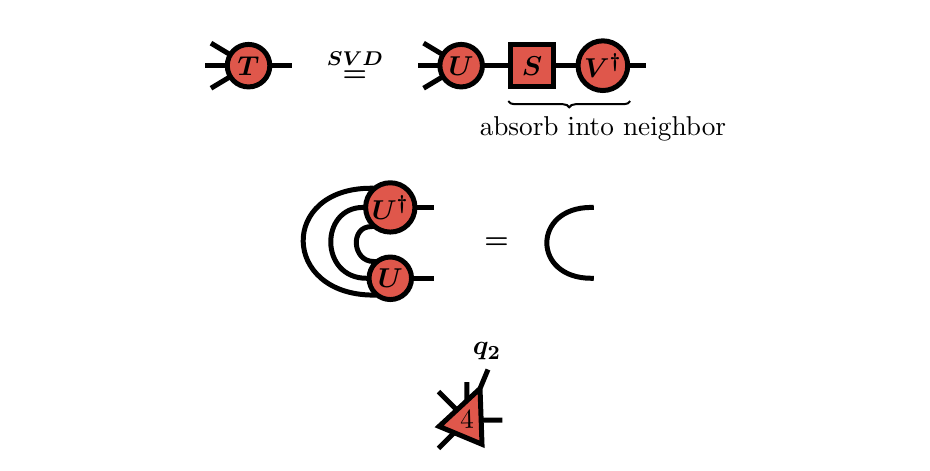
Figure 3: With an SVD, we can orthogonalize a tensor towards one of its neighbors with which it shares an index. Top: Tensor T is reshaped into a matrix and the U - matrix of its SVD is used as new tensor. S · V † is absorbed into the neighboring tensor. Middle: Graphical representation of U † · U = (cid:49) . Bottom: A tensor that is normalized towards one of its neighbors is depicted as a triangle pointing in the direction of this neighbor. The picture shows tensor 4 of the TTN in Fig. 1 orthogonalized